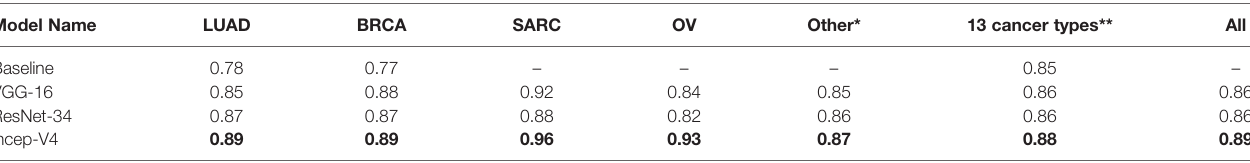
TABLE 2 | Patch classi fi cation F-score results.